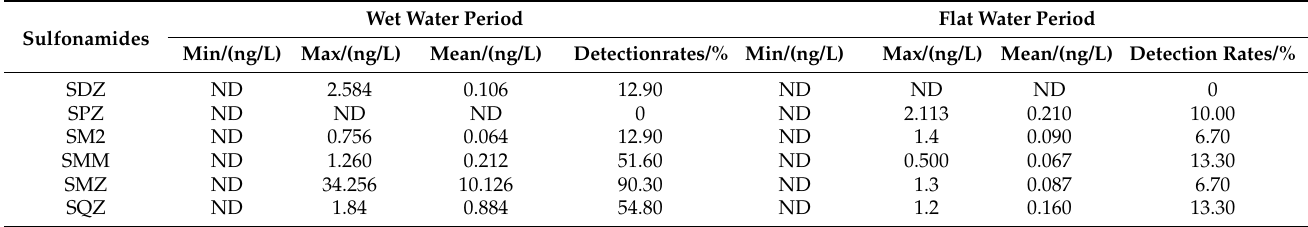
Table 4. Concentration levels of sulfonamides in the Shaanxi section of the Weihe River.